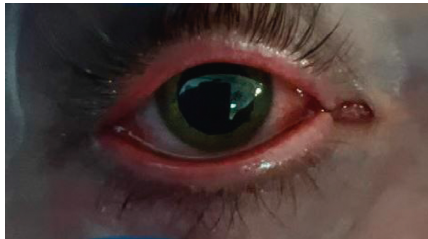
Figure 5: Right eye redness.